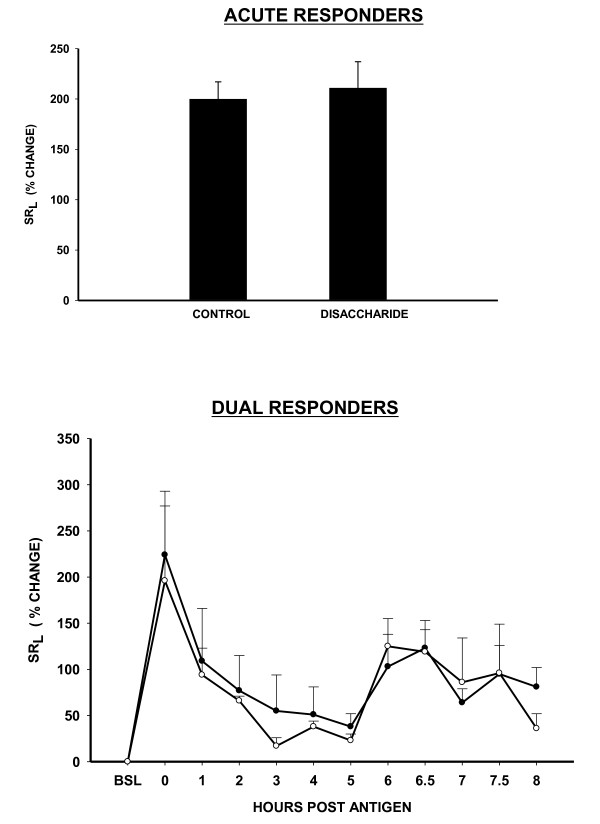
Failure of inhaled heparin disaccharide to inhibit allergic bronchoconstrictor responses in sheep. Top: Antigen-induced % change in specific lung resistance (SRL) ± SE in "Acute Responders" with (4 mg/kg; n = 3) and without pretreatment (control). Bottom: "Dual Responders" (1 mg/kg, n = 3,) without (control; open circles) and after treatment (solid circles) with inhaled disaccharide.